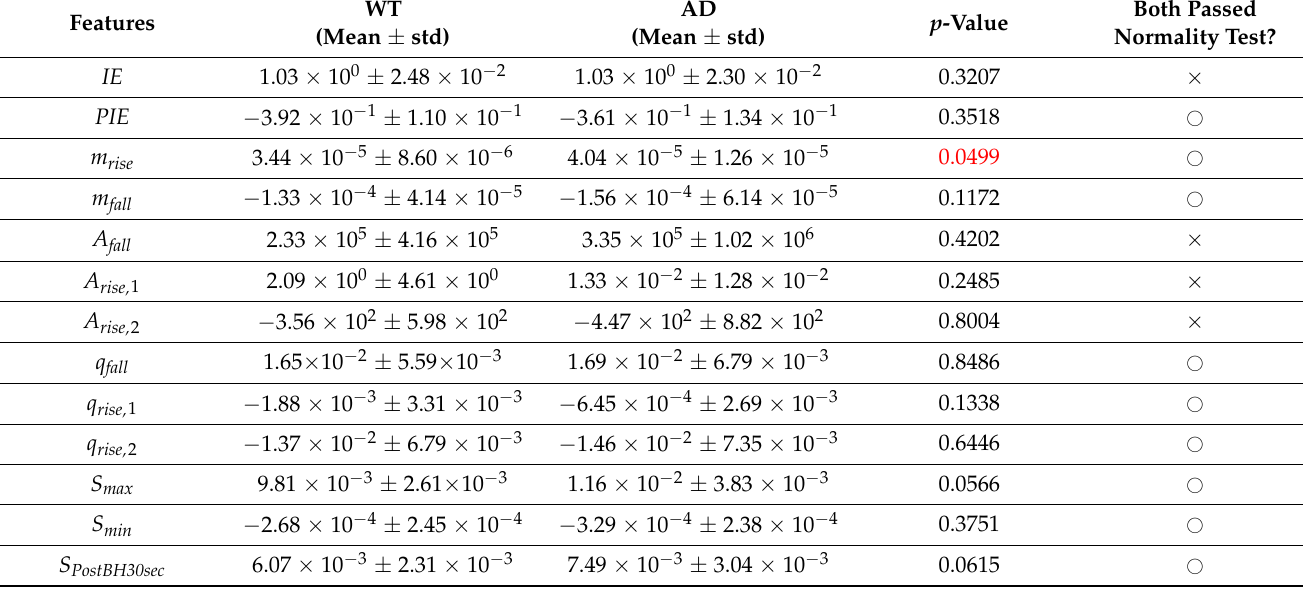
Table 3. Summary of 13 hemodynamic features of − ∆ OHb from WT and AD. std: standard deviation. p -value lower than 0.05 is highlighted using red